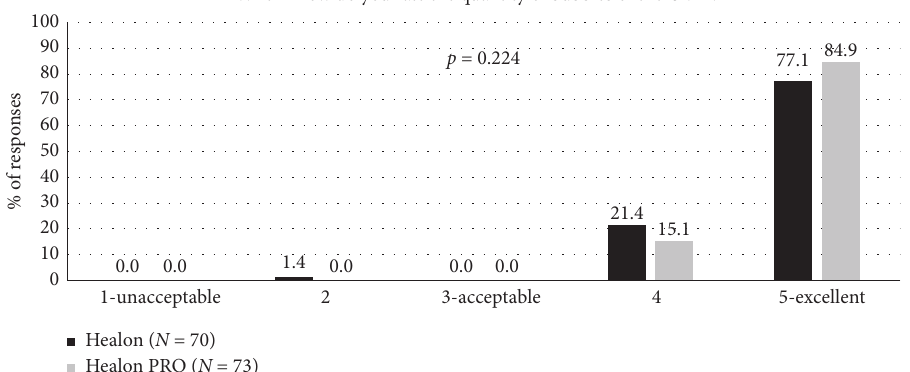
Figure 4: Quantity of bubbles during surgery for the Healon control and Healon PRO test groups, where “user acceptable” indicated a response of “3,” “4,” or “5.”